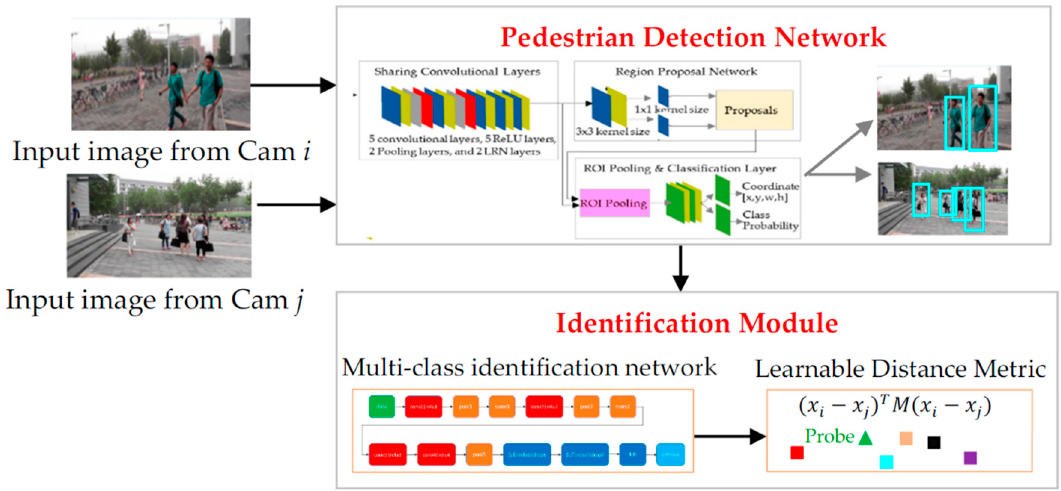
Figure 1. Overview of the proposed deep integrated person detection and identification system (IPnetwork).